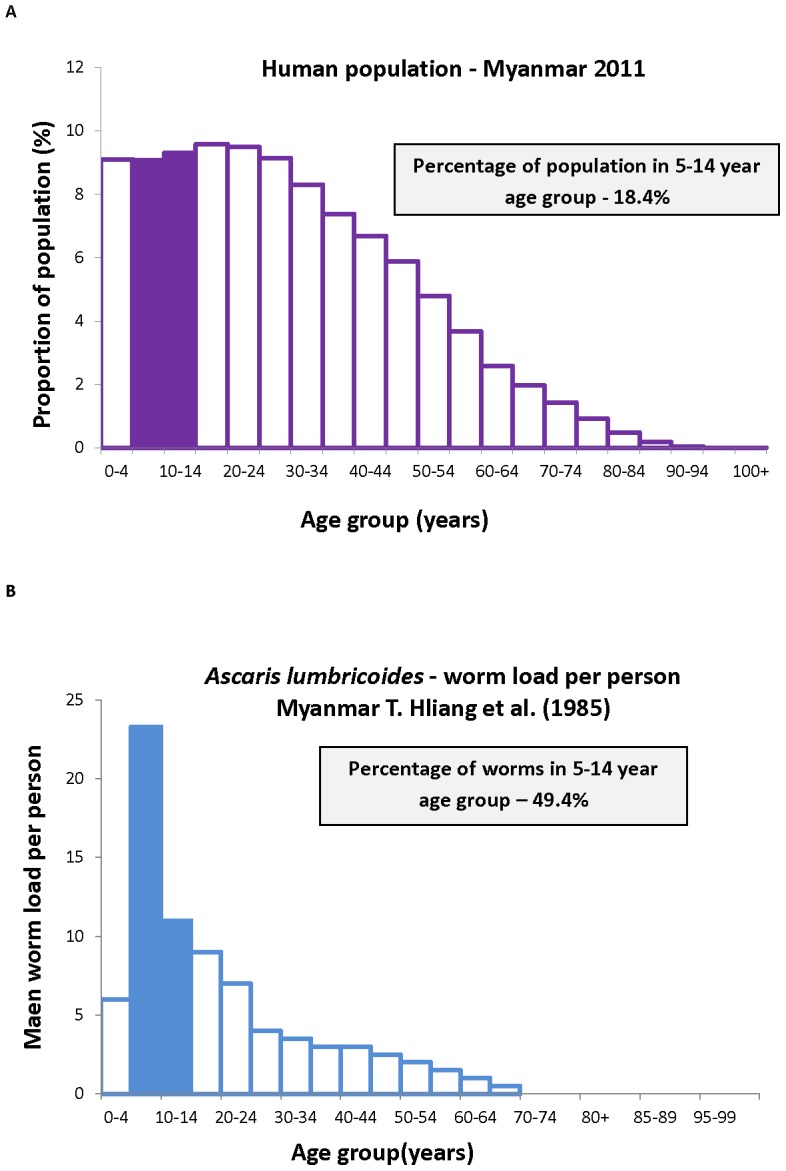
The proportion of A. lumbricoides worms in children aged 5–14, calculated from
equation 3
.The demography of the population, A, results in a proportion of 18.4% of the population aged 5–14 years old [45]. Combining this distribution with B the distribution of worms per person by age [57] gives 49.5% of worms in the school-aged group.